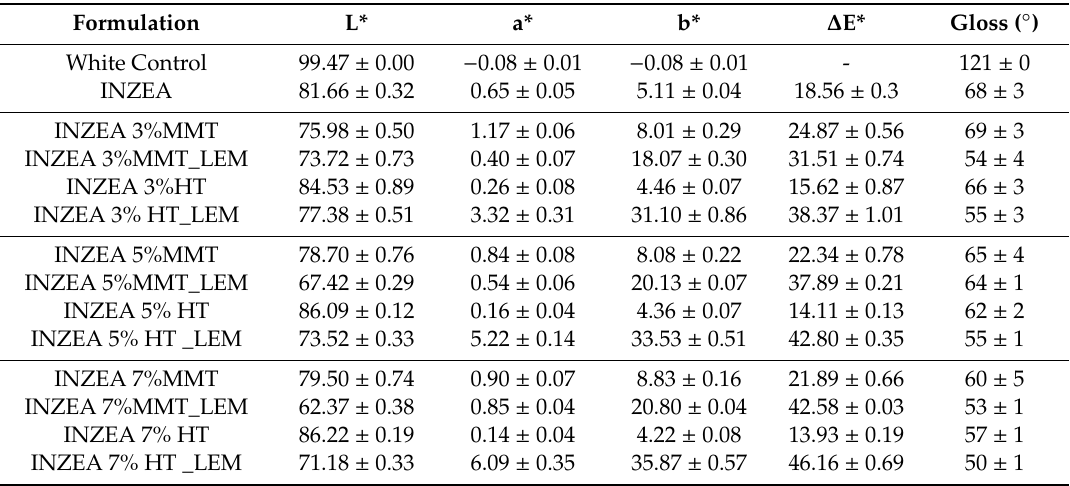
Table 6. CIELAB parameters for INZEA bio-nanocomposites with MMT and HT lemon hybrid pigments (m ± SD; n =